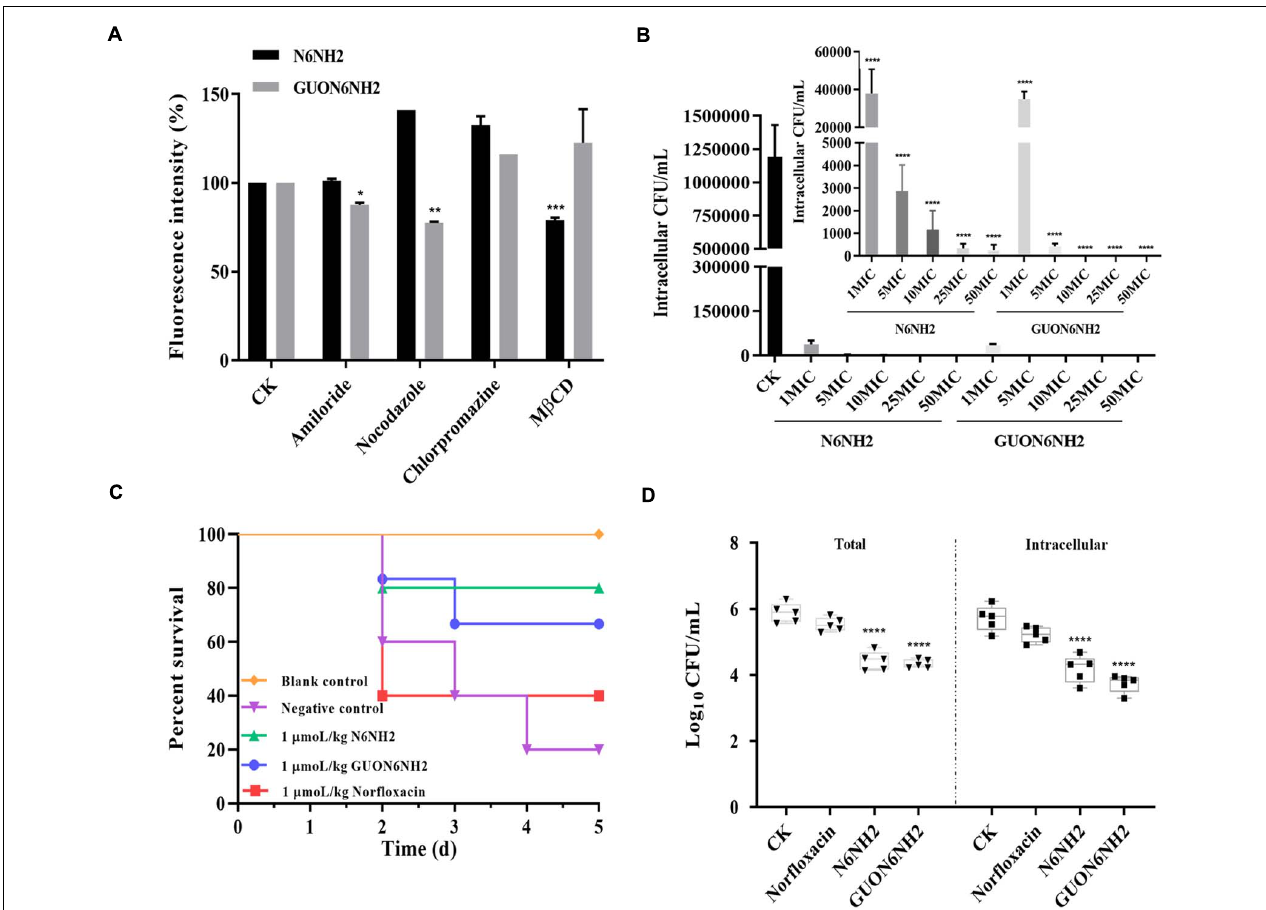
FIGURE 7 | Uptake mechanism and intracellular activity of FITC-N6NH2 and FITC-GUON6NH2 in RAW 264.7 cells and in mice. (A) Effect of different endocytosis inhibitors and low temperature on the uptake of FITC-labeled peptides in RAW 264.7 cells. Cells were preincubated with different endocytosis inhibitors (including amiloride, nocodazole, chlorpromazine, and M β CD, respectively) for 1 h before incubation with 10 × MIC FITC-labeled peptides for 4 h. External fluorescence was quenched with 0.4% Trypan blue, and the fluorescence intensity was then measured by flow cytometry. CK is the negative control. N6NH2 was transported into cells through lipid rafts, but GUON6NH2 entered cells through macropinocytosis and microtubule polymerization. (B) Intracellular activity of N6NH2 and GUON6NH2 against E. tarda in RAW 264.7 cells. The ordinate showed bacterial reduction per mL of broth in RAW 264.7 cells after 18 h of incubation with peptides compared to the original inoculum. GUON6NH2 had higher intracellular activity against E. tarda than N6NH2 in RAW 264.7 cells. (C) Survival of mice. The survival rate of mice of 1 µ moL/kg N6NH2 was 80%, which was a little highter than that with 1 µ moL/kg GUON6NH2 (60%). Peptides have a higher survival rate than antibiotic. (D) Intracellular activity of N6NH2 and GUON6NH2 against E. tarda in the mouse peritonitis model. GUON6NH2 had higher efficacy against E. tarda than N6NH2 and norfloxacin in mice. (*) indicates the significance between control and treatment groups. * p < 0.05; ** p < 0.01; *** p < 0.001; **** p <